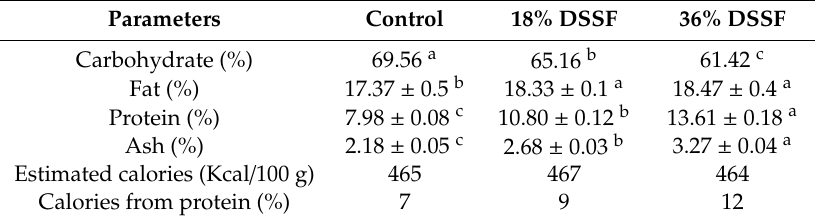
Table 3. Proximate composition of control and defatted sunflower seed flour biscuits.